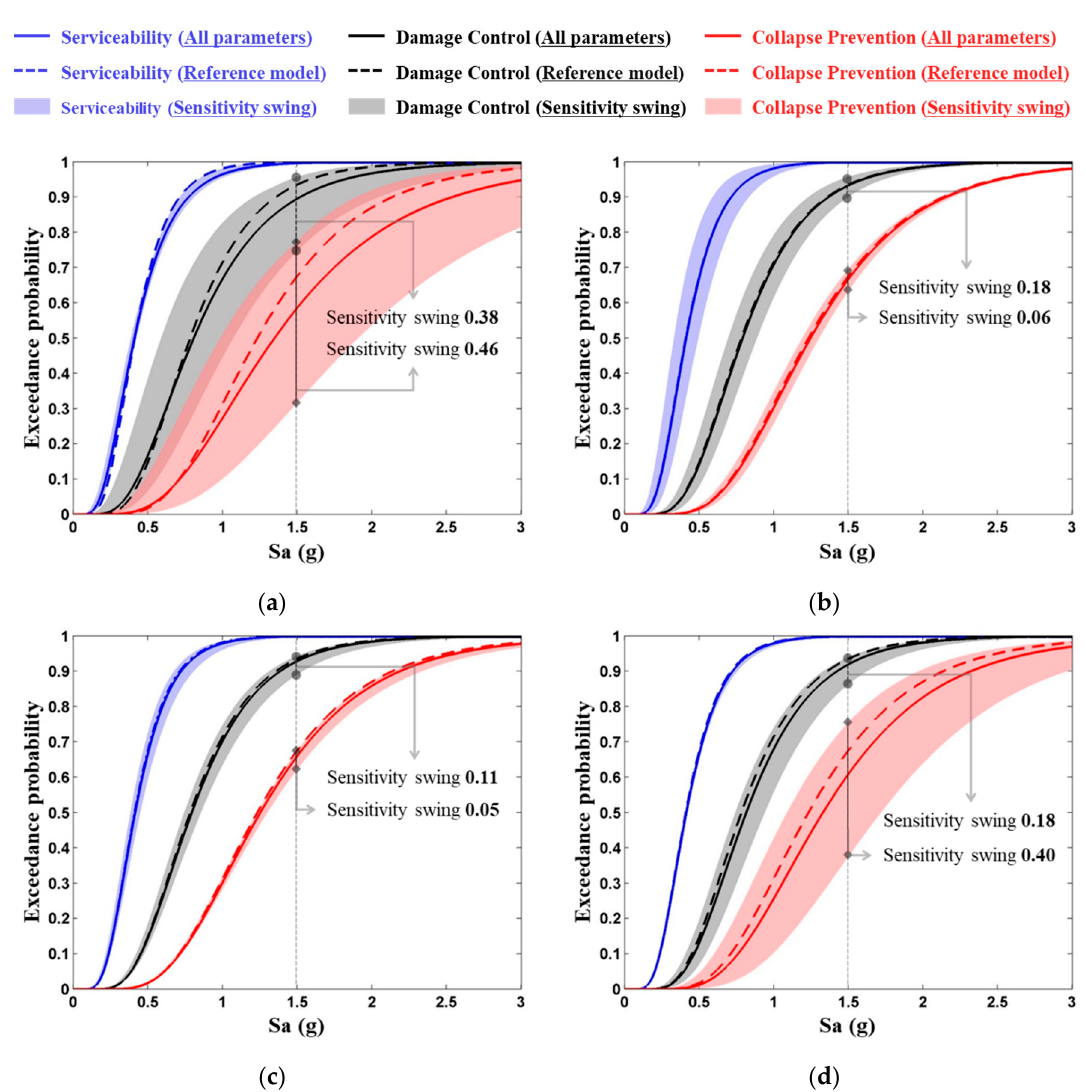
Figure 7. The sensitivity swing of the seismic vulnerability curve at each the limit state in the global level: ( a ) concrete strength; ( b ) yield strength; ( c ) longitudinal reinforcement ratio; ( d ) volumetric ratio of transverse reinforcement.